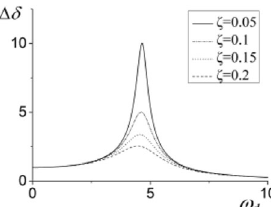
Fig. 1 Variation of power angle amplitude with disturbing source frequency under different damping